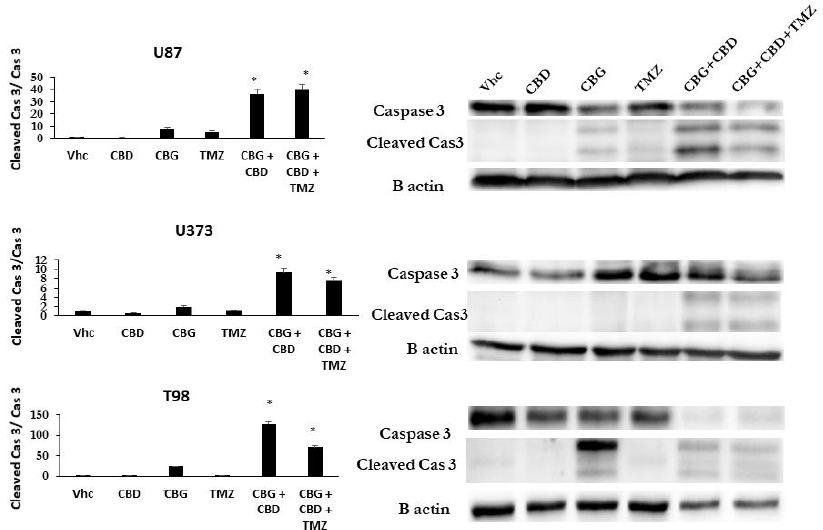
Figure 4. CBG apoptotic pathways processed via induced caspase-3 cleavage in GB cell lines. Apoptosis pathways were analysed by western blot analysis and densitometric quantification of caspase-3 protein levels, as described in Material and Methods (Section 2.11). Representative blots show protein levels of caspase-3 and its cleaved products. Densitometric values were normalized to B actin, which was used as a loading control. Cleaved caspase-3 values were then normalized to non-cleaved caspase-3 and shown on the left graphs as averaged values of three separate experi- ments (* p < 0.05 treated vs untreated